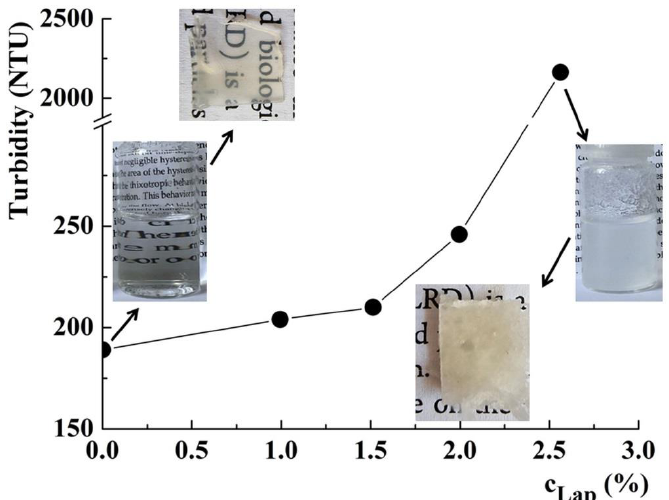
Figure 2. Effect of c Lap on the turbidity of dispersions with 3% PEG and 0.2% CS; visual appearance of dispersions/films free of Lap and with 2.5% Lap.